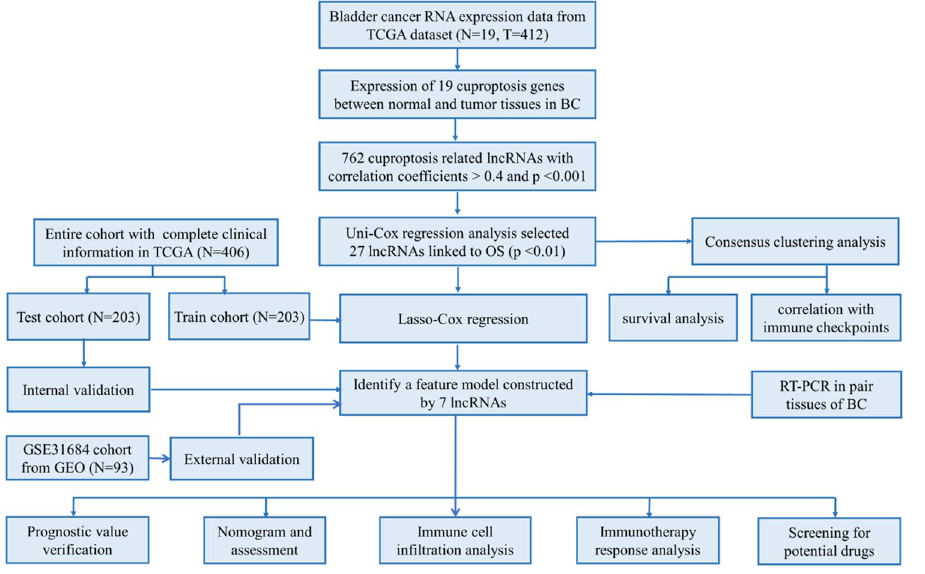
Figure 1. Overall flow chart of the